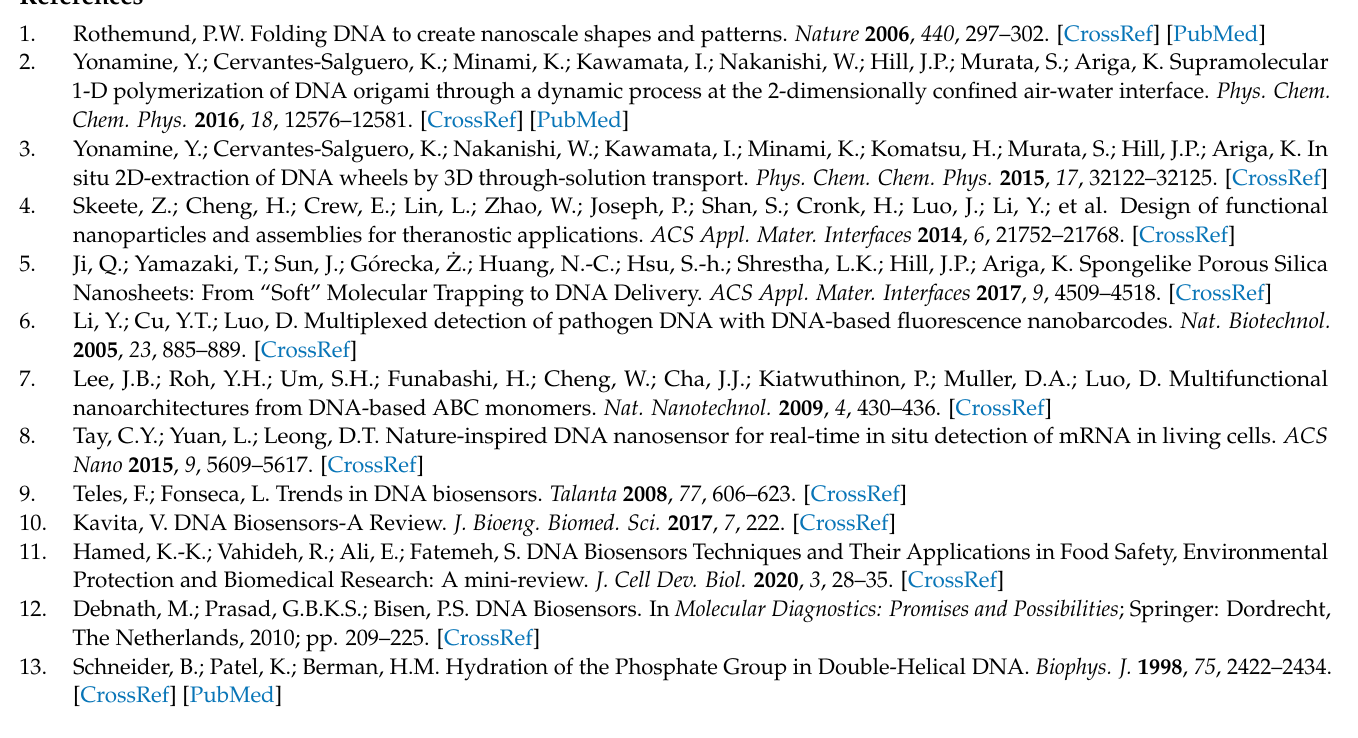
Table S1: Limit of Detection to humidity [34,36,42,48–61]; Table S2: Limit of Detection to trace amounts of water in organic